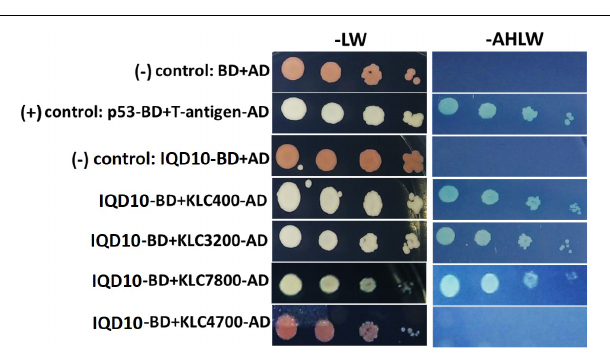
FIGURE 6 | Yeast two-hybrid interaction analysis of PdIQD10 with Kinesin light chain related 1 (KLCR) proteins. Interaction analysis of PdIQD1 with four chosen KLC proteins using yeast two-hybrid approach. PdIQD1 interacts with KLC400, KLC3200 and KLC7800 but not with KLC4700. Positive control and the empty vector negative control are also